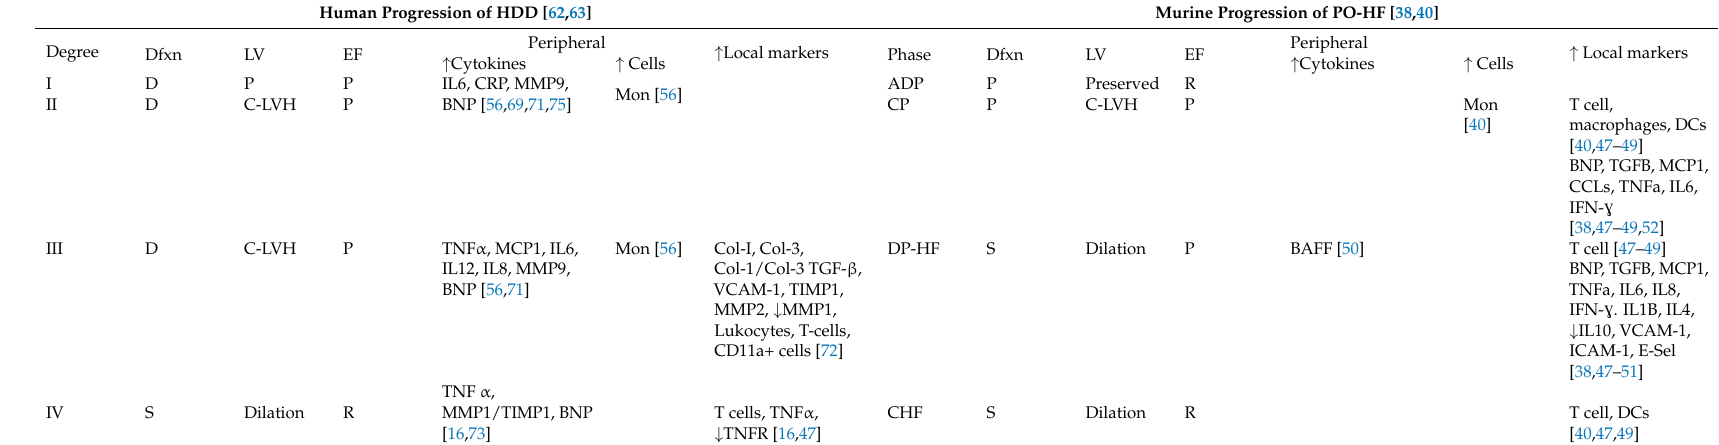
Table 3. Comparison between human and murine progression of